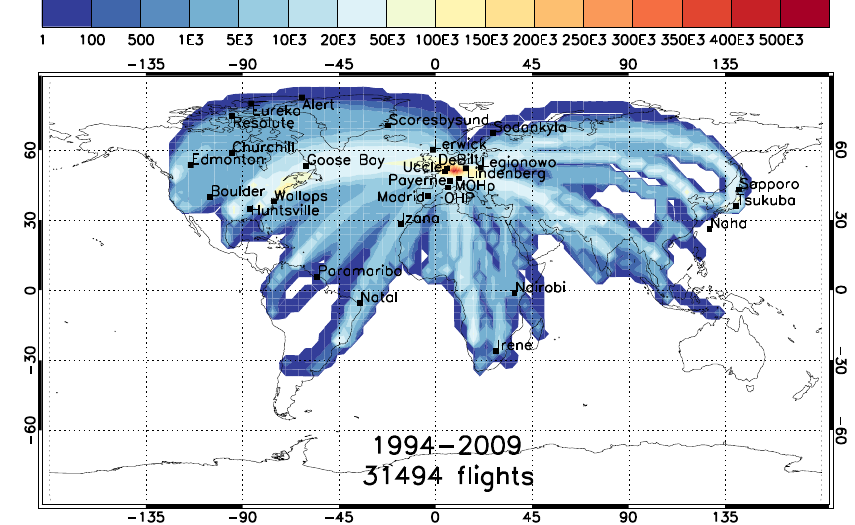
Fig. 1. Distribution of the ozonesonde stations considered in this work (black squares) and total number of measurements from the MOZAIC aircraft program (1994–2009), summed up over a 3 ◦ × 3 ◦ latitude × longitude grid. The colour bar indicates the total number of 1-minute averaged MOZAIC measurements. MOHp denotes the Meteorological Observatory at Hohenpeißenberg, Germany; OHP the Observatory Haute Provence, France.